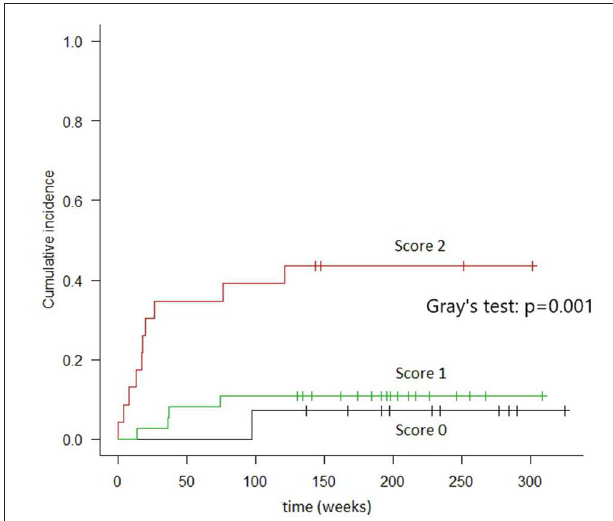
FIGURE 2 | Cumulative incidence of TRM in groups of patients identified by combined cytokines score. In “score 0” patients (both TIM-3 AND sIL2-R α below the threshold) the TRM, at 2 years, resulted 7.1%. In “score 1” patients (either TIM-3 or sIL2-R α over the threshold), the TRM was 10.8%. In “score 2” patients (both TIM-3 and sIL2-R α over the threshold), TRM was 41.7% (Gray’s test: p = 0.001).